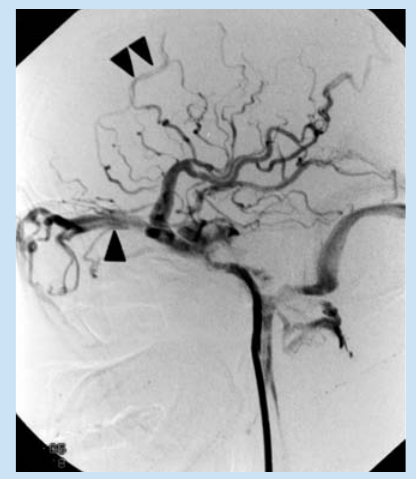
Fig. 5a. Lateral internal carotid angiogram showing fistula with venous drainage into the superior oph- thalmic vein (arrow) and cortical veins (double arrows).